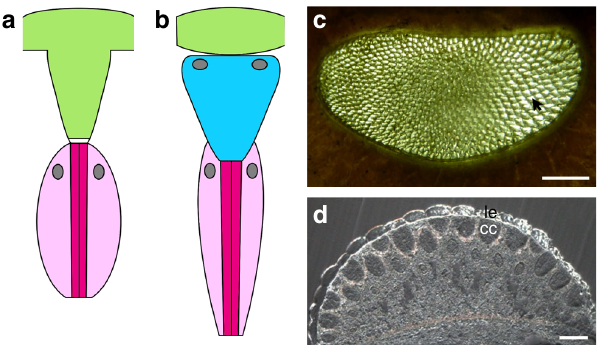
Fig. 1 The two major compound eye types of Recent euarthropods. a , b Simpli fi ed schemes of the dioptric apparatus of a single unit (ommatidium) of a Recent xiphosuran eye ( a ) and a Recent mandibulate eye ( b ). Pigment cells are omitted. Light green: cuticular lens, turquoise: crystalline cone, white: vitreous cells, dark magenta: rhabdom, light magenta: retinula cell bodies gray: cell nuclei. a The cuticular lens forms a cone-like extension. The light is guided via a small transparent vitreous region of about a hundred cells to the rhabdom, i.e. the light-perceiving microvilli of the circularly arranged retinula cells. b A relatively fl at cuticular lens is combined with a cellular transparent crystalline cone. The position of the nuclei of the crystalline cones and the retinula cells differ among the mandibulate taxa. c Micrograph of the internal view of a compound eye of the horseshoe crab Limulus polyphemus with numerous cuticular cone-like projections (arrow). d cross-section through the eye of the centipede Scutigera coleoptrata showing biconvex cuticular lenses (le) and the cellular crystalline cones (cc). Scale bars: 200 μ m ( c ), 50 μ m ( d